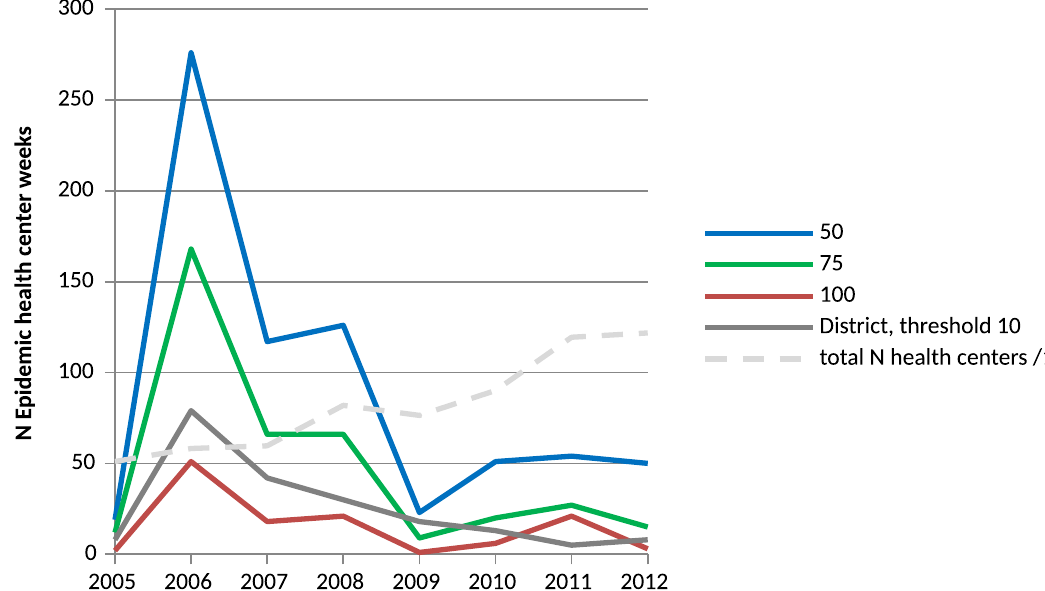
Figure 3. Number of meningitis epidemic weeks detected according to different cut-offs that were applied at the level of health centres (50, 75 or 100 weekly cases per 100,000) or at the level of the district (10 cases per 100,000). 14 health districts in Burkina Faso, 2005–2014. For the periods January–June 2004 and January 2013– December 2014, data from only nine districts were available; these periods therefore were not included in the graph.